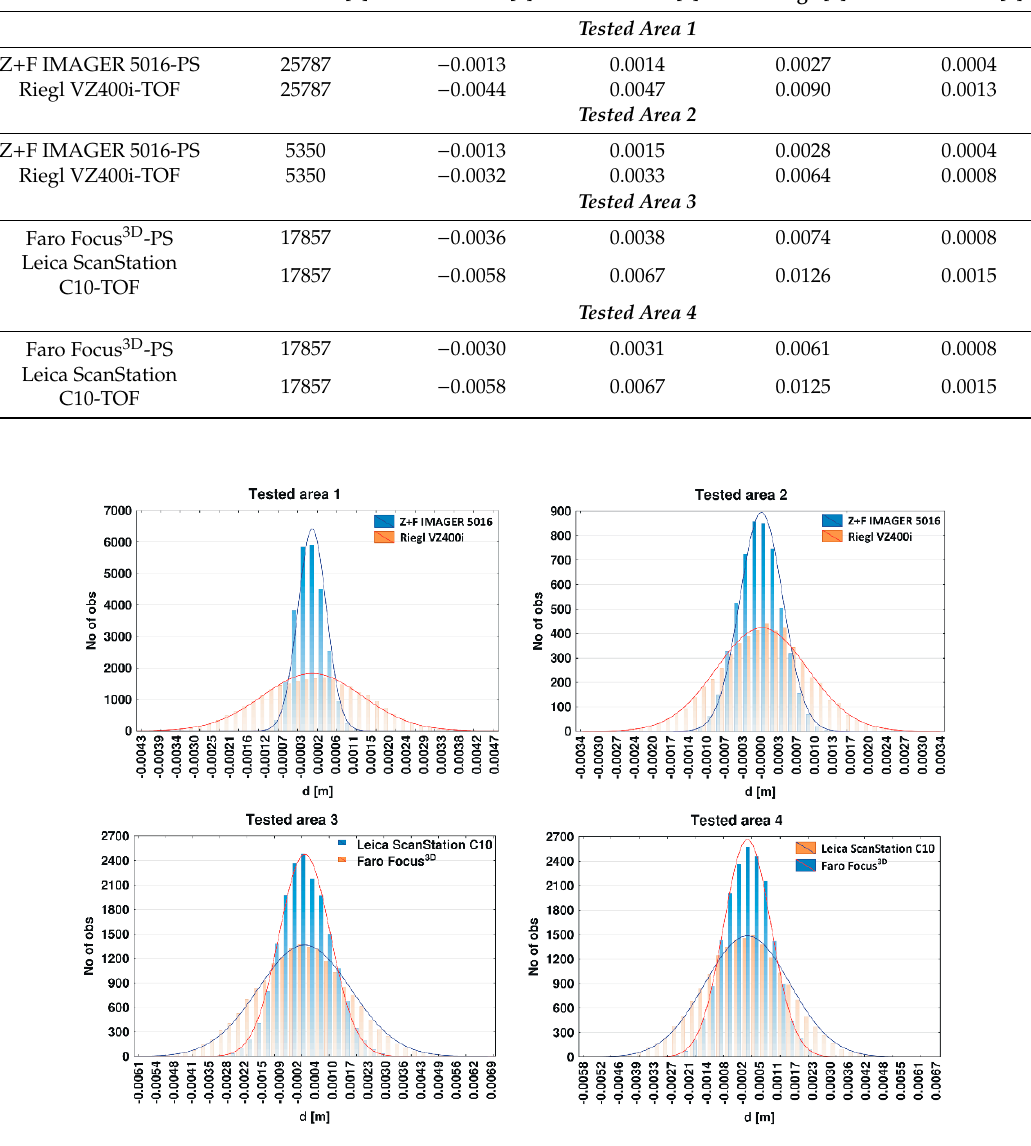
Figure 10. Histograms of distance measurement errors of the tested